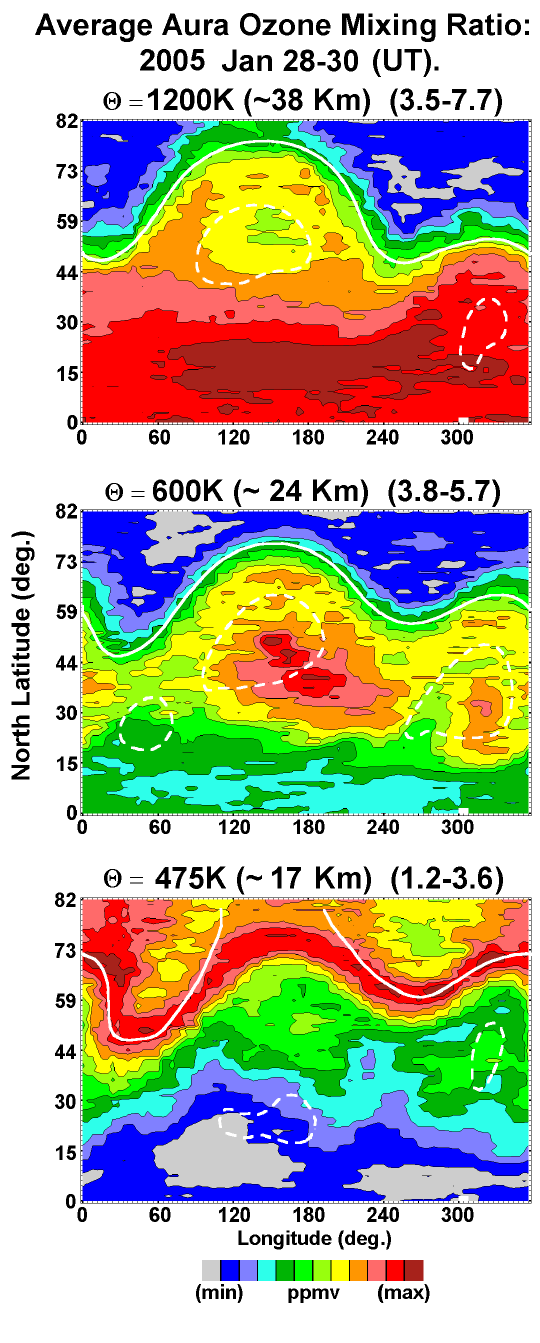
Fig. 10. Polar cylindrical hemispheric contour plots of the 3-day average mixing ratios of ozone (Aura MLS) for three heights. These are for a day (29 January) within the 1 February “warming event” defined in Sect. 3: “the end of a warming trend or “temperature disturbance” (typically ∼ 10 days in duration) as indicated by zonal mean MetO temperatures at 60–70 ◦ N and 10hPa”. The edge of the polar vortex as determined by the Q-diagnostic using MetO (data assimilation model) is shown with a solid white line (see text); the edge of the anticyclone is located with a dashed white